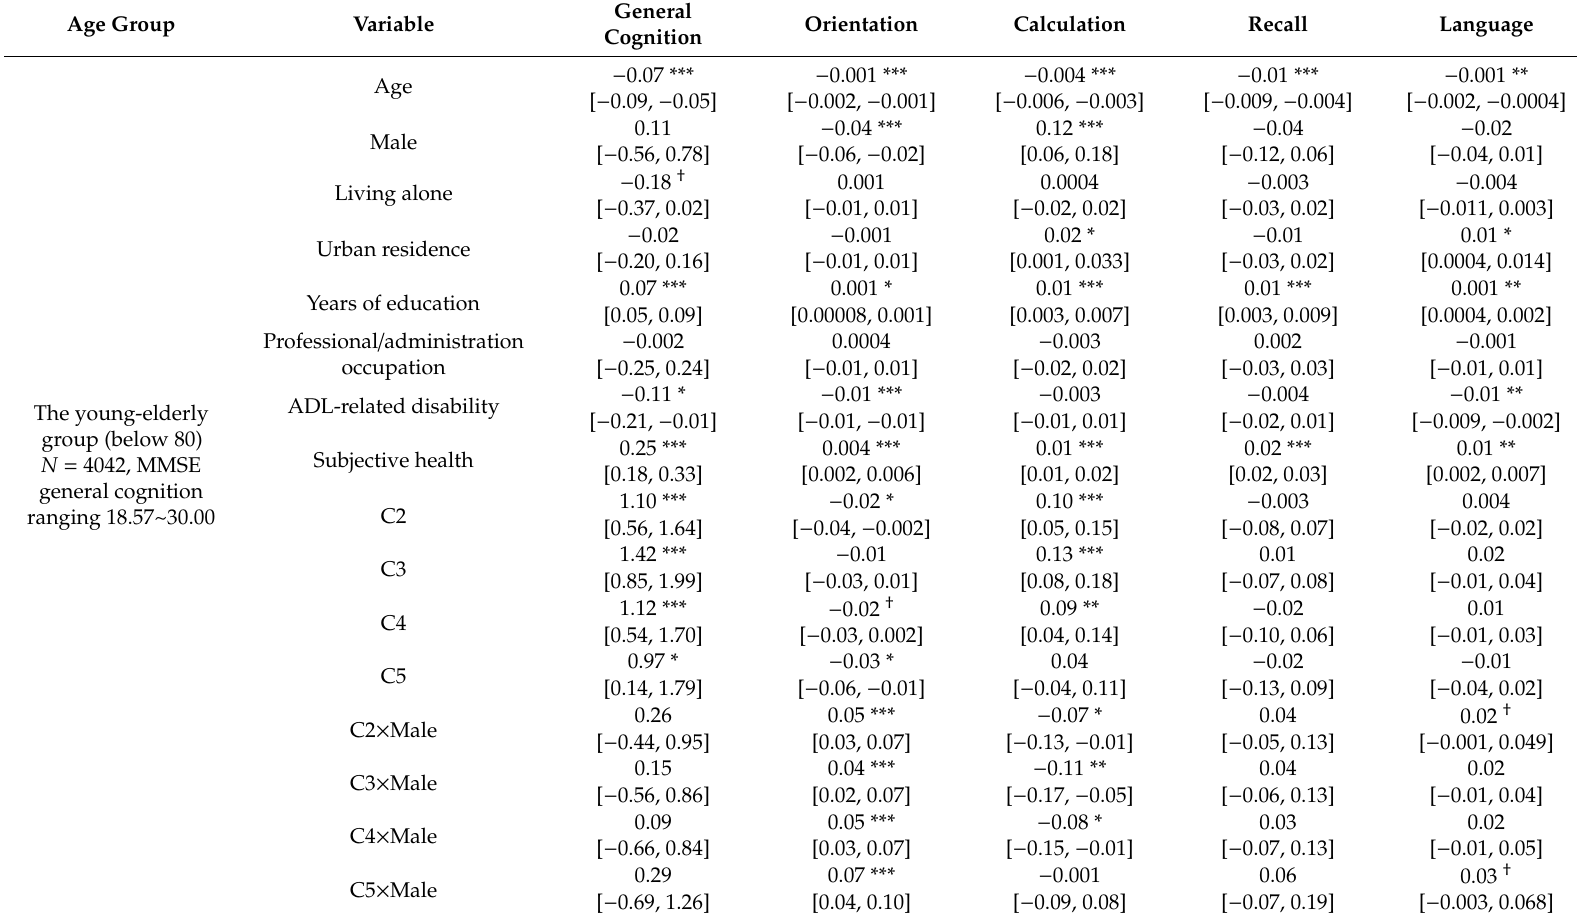
Table 3. Unstandardized Beta Coe ffi cients and 95% CI of Regression Model 3 for Cognitive